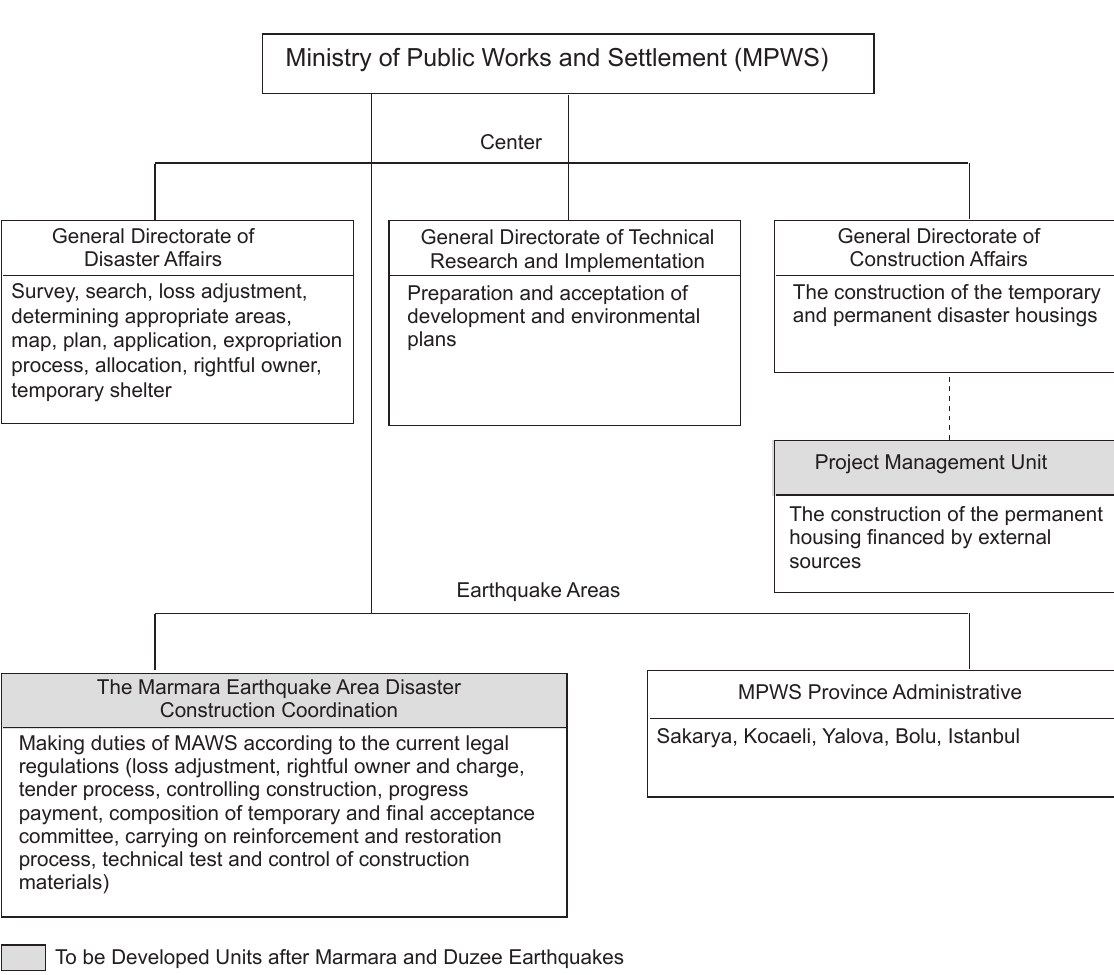
figure 2. MPWS organization scheme after Marmara and Düzce